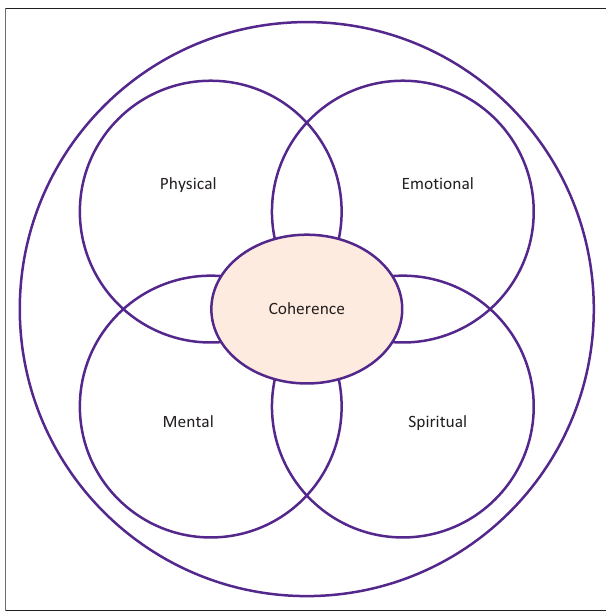
FIGURE 1: Basic elements of the whole